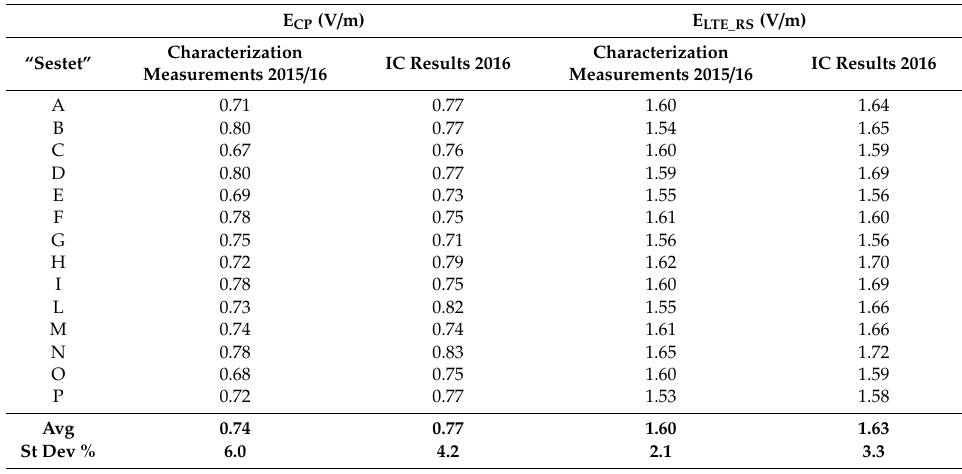
Table 4. Comparison of the results of characterization measurements (made in 2015 and 2016) and those of participants during IC